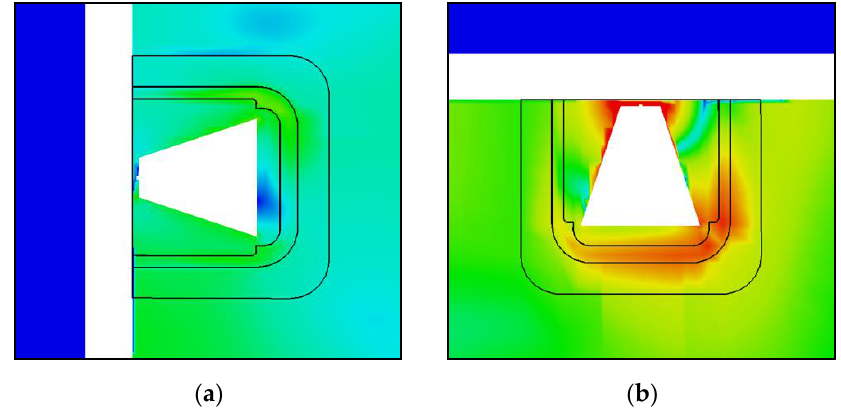
Figure 13. Electric field distribution around drain valve sensors. ( a ) Sensor 20; ( b ) sensor 32.